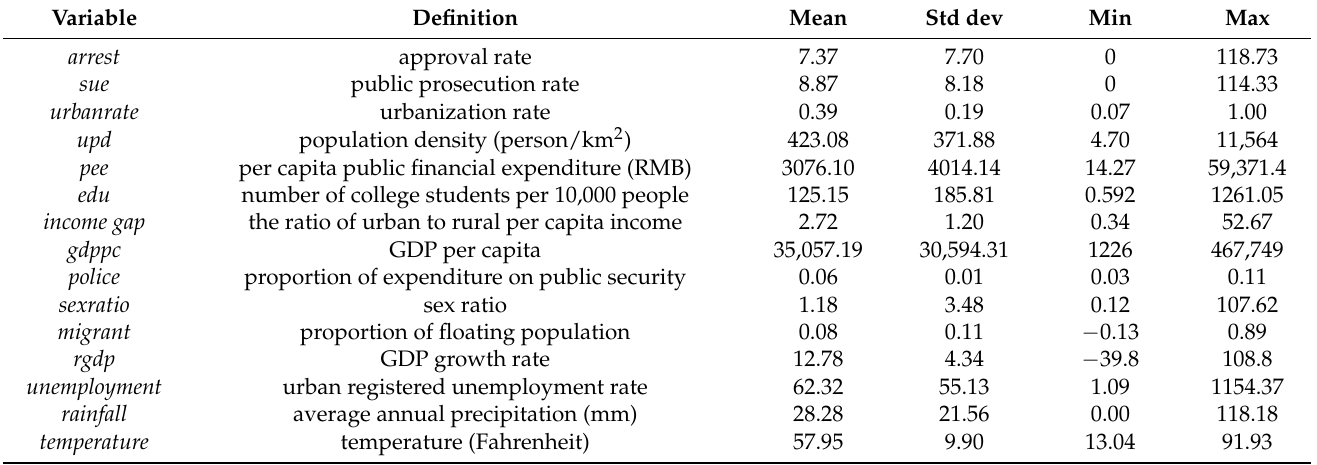
Table 1. Definitions of variables and